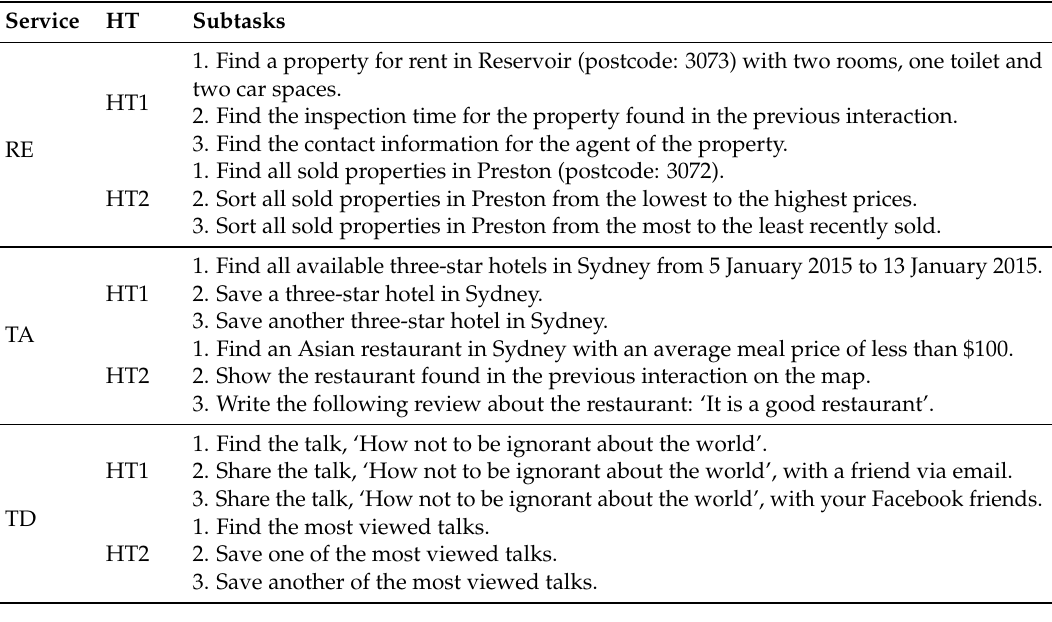
Table 2. Horizontal tasks for the test